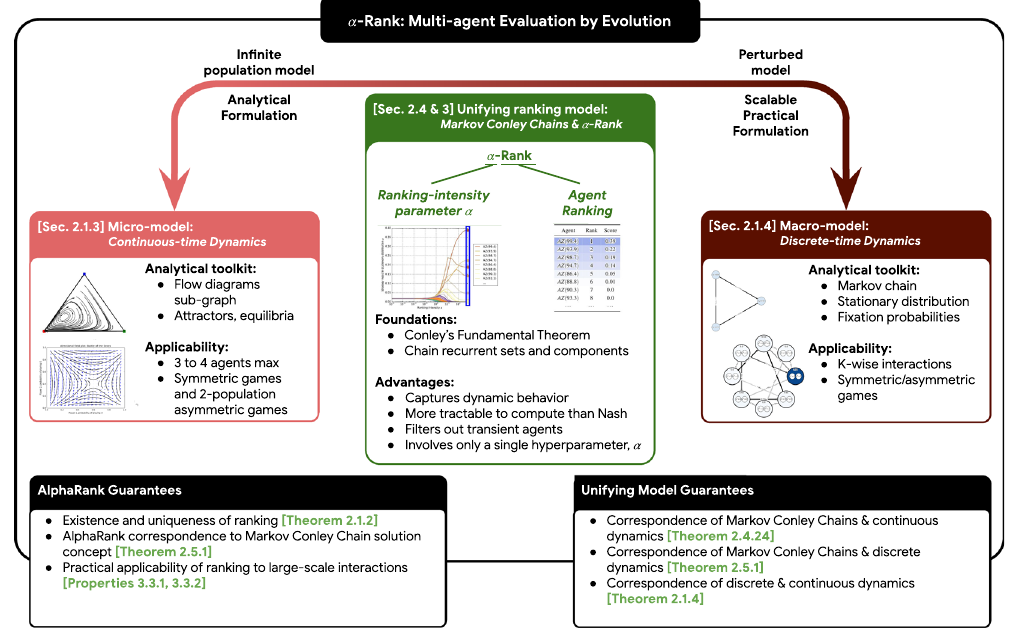
Figure 17. A retrospective look on the paper contributions. We introduced a general descriptive multi-agent evaluation method, called α -Rank , which is practical in the sense that it is easily applicable in complex game- theoretic settings, and theoretically-grounded in a solution concept called Markov-Conley chains (MCCs). α - Rank has a strong theoretical and specifically evolutionary interpretation; the overarching perspective considers a chain of models of increasing complexity, with a discrete-time macro-dynamics model on one end, continuous-time micro-dynamics on the other end, and MCCs as the link in between. We provided both scalability properties and theoretical guarantees for the overall ranking